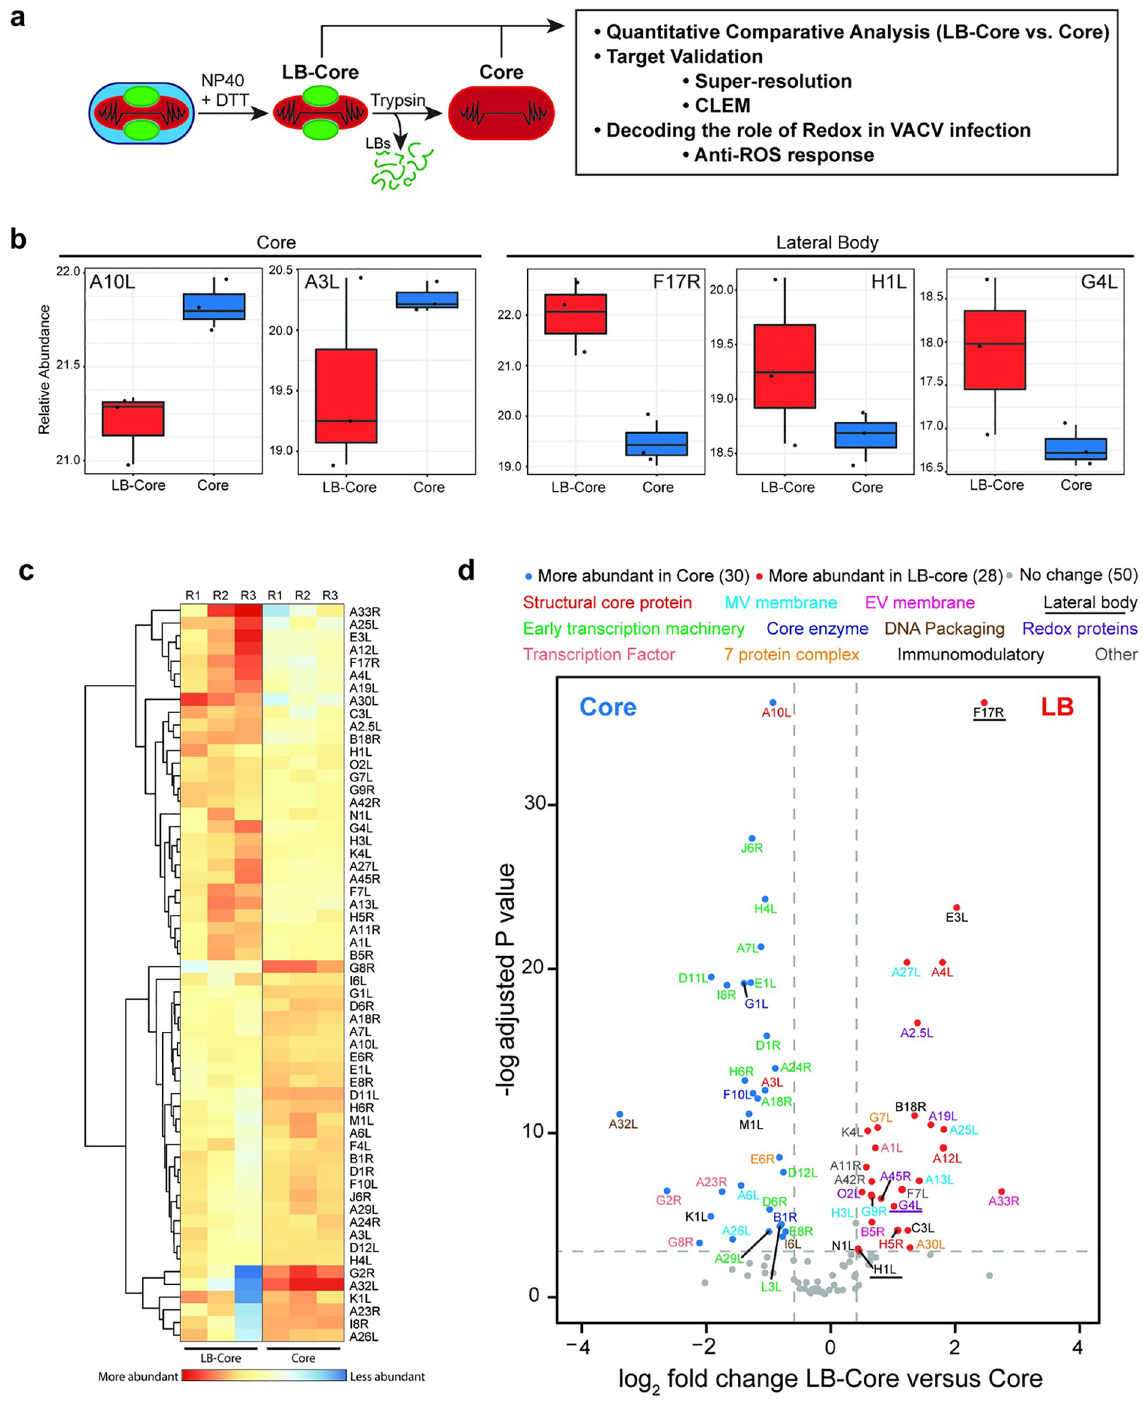
Fig 1. Defining the VACV LB spatial proteotype. (a) Schematic of controlled degradation of purified VACV MVs used in this study (details in Materials and Methods). (b) Relative abundance plots of known core (A10L, A3L) and LB (F17R, H1L, G4L) proteins across LB-Core and Core fractions. (c) Heat map showing the relative abundance of VACV proteins between LB-Core and Core fractions. (d) Relative abundance of viral proteins in LB-Core versus Core fractions. Proteins are colour coded with regard to LB-Core vs. Core abundance: more (red), less (blue) or no difference (grey). Experiments were performed in triplicate and significance scored as a minimum of two-fold greater in LB-Core vs. Core samples. An adjusted p-value � 0.08 cut off was set using the adjusted p-value of the bone fide VACV LB protein H1L (c-d).